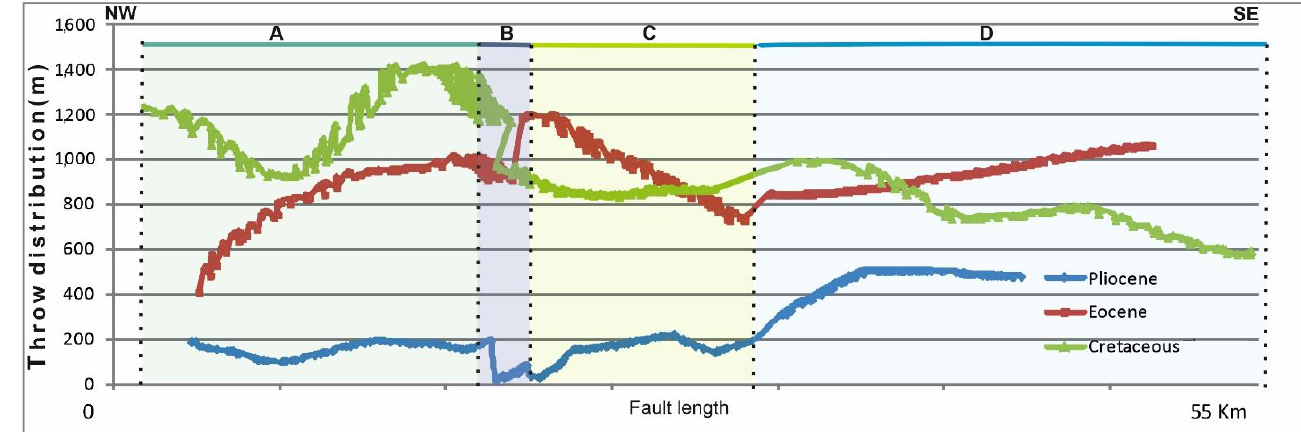
Table 1. Name, length, and vertical throw of the computed fault segments related to the Paleocene– Eocene (green), Miocene–Pliocene (red), and Pleistocene (blue) fault